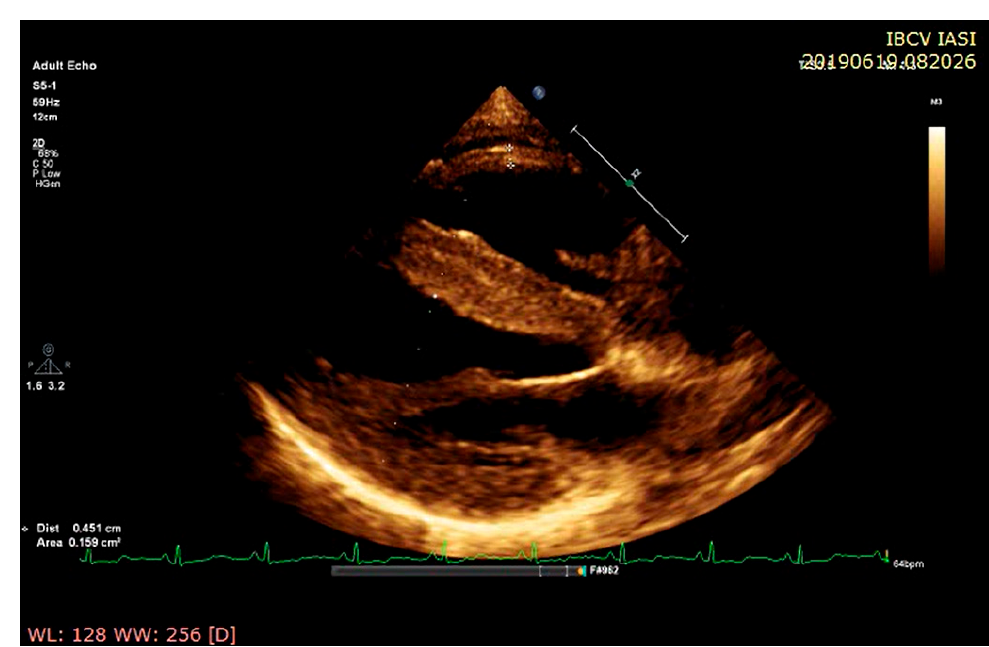
Figure 2. Echocardiographic assessment at rest in a young female with ATTR amyloidosis: parasternal long-axis view demonstrating concentric left ventricular pseudohypertrophy with concomitant right ventricular free wall hypertrophy.